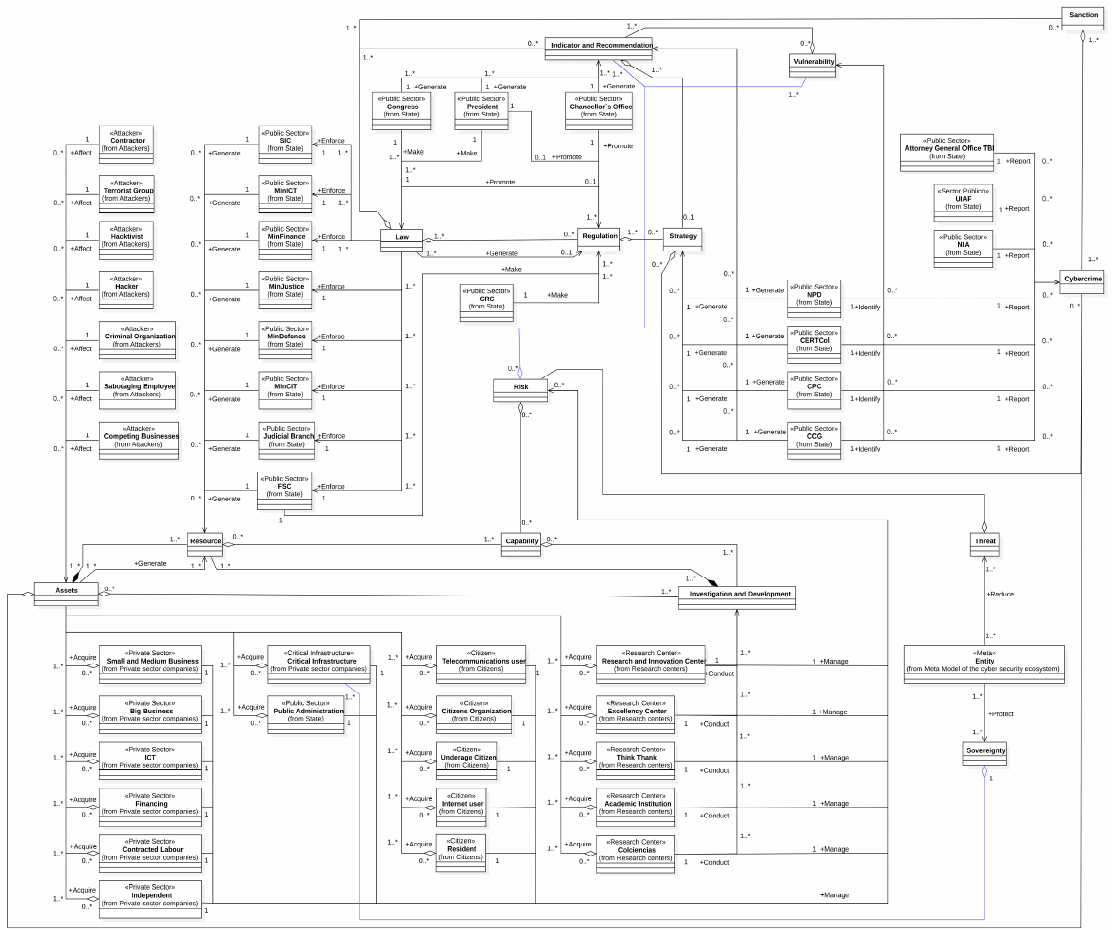
Figure 14. Domain Model of the Cyber Security Ecosystem of Colombia.